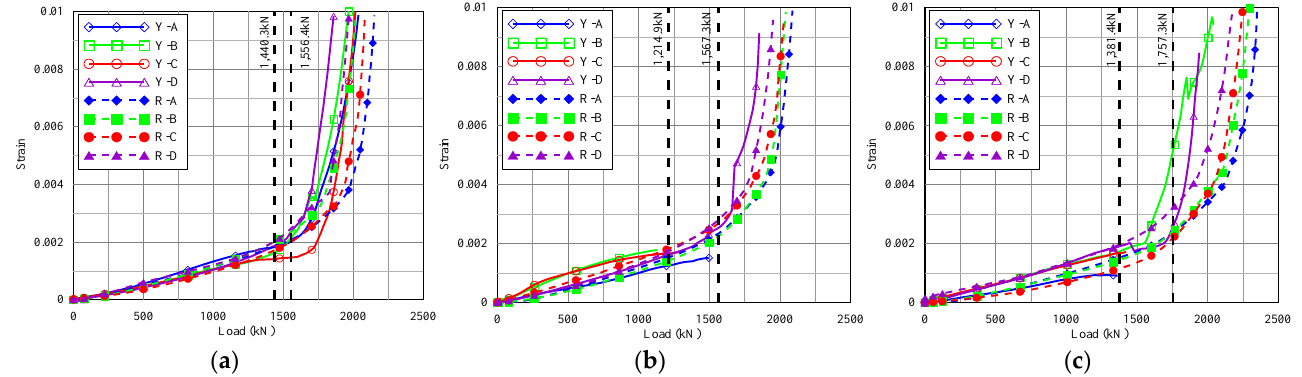
Figure 7. Load – strain curves. ( a ) SD400-D16-3M, ( b ) SD500-D16-3M and ( c ) SD500-D19-3M. Figure 7. Load–strain curves. ( a ) SD400-D16-3M, ( b ) SD500-D16-3M and ( c ) SD500-D19-3M.